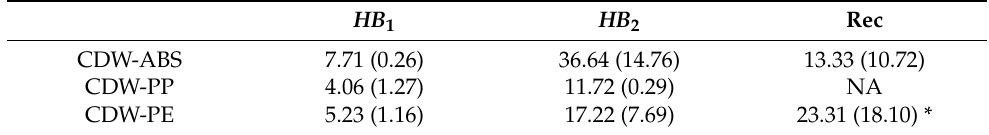
Table 1. The strength properties (Brinell hardness ( HB 1 ), resistance to indentation ( HB 2 ), and recovery rate (Rec)) of the studied materials with standard deviations in parentheses.